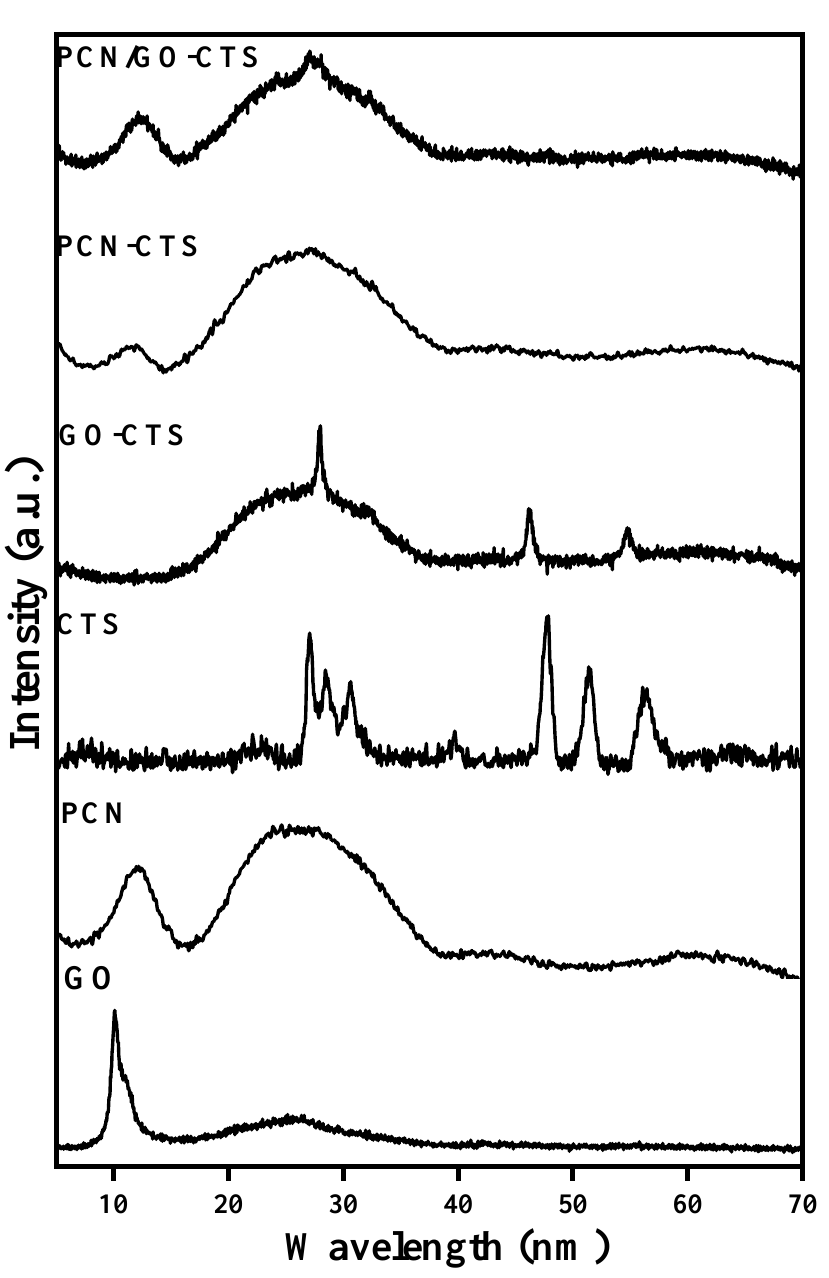
Figure 2. XRD spectra of GO, PCN, CTS, GO-CTS, PCN-CTS, and PCN/GO-CTS. Figure 3 shows the SEM, TEM, and EDS spectra of CTS. SEM image of CTS revealed uniform, agglomerated spherical shaped nanocrystals, which was also supported by the TEM image. EDS spectra showed the presence of copper (Cu), tin (Sn), and sulfur (S) in the ratio of 3.14, 1, and 3.45 respectively, which is in agreement with the expected stoichiometric ratio. The SEM and TEM images of the composites showed that there was a significant difference in the level of agglomeration of CTS in the three composites. Figure S1 (in Supplementary Materials) shows the SEM, TEM, and EDS spectra and elemental mapping images of PCN-CTS. CTS nanoparticles on PCN were more agglomerated than the CTS deposited on GO, and the elemental mapping images showed the presence of Cu, Sn, S, C, and N, which confirms the incorporation of PCN and CTS. As shown in Figure S2, the SEM and TEM images of rGO-CTS revealed a lower level of aggregation of CTS particles when incorporated onto rGO. The elemental mapping images